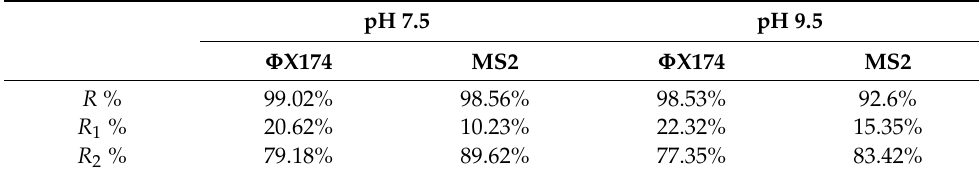
Table 4. Virus removal and recovery at different pH.